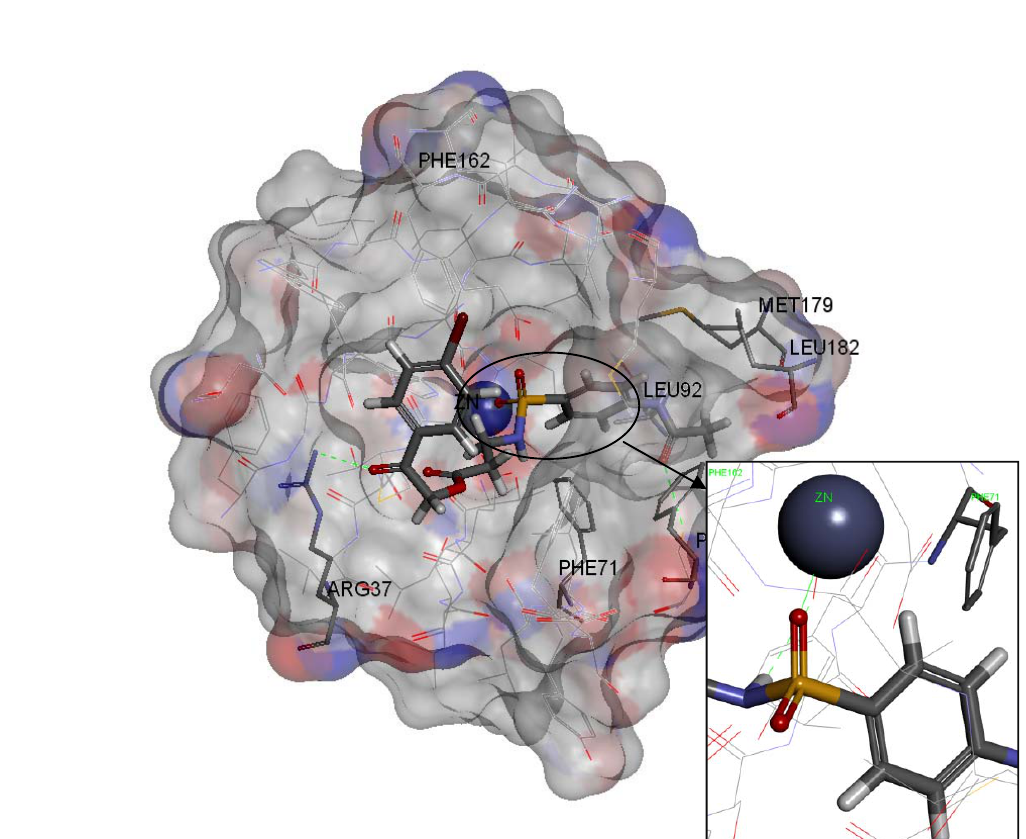
Figure 11. Zinc13100715 docked inside the Glo-1 active site .